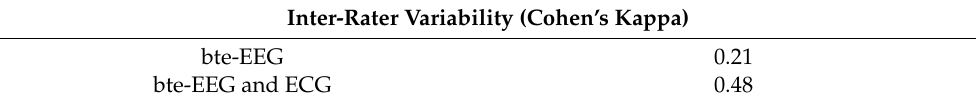
Table 3. Inter-rater variability between the two readers for each experimental setup.